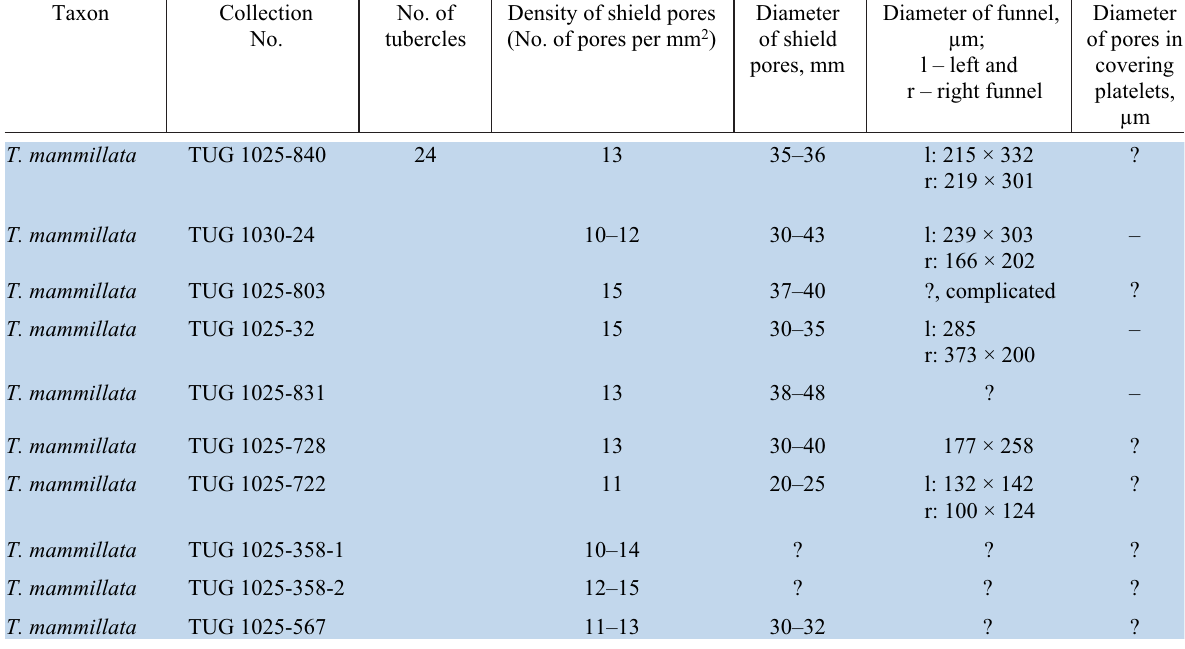
Table 3. Numerical data on headshield pores and pores in covering platelets and funnels of Tremataspis mammillata